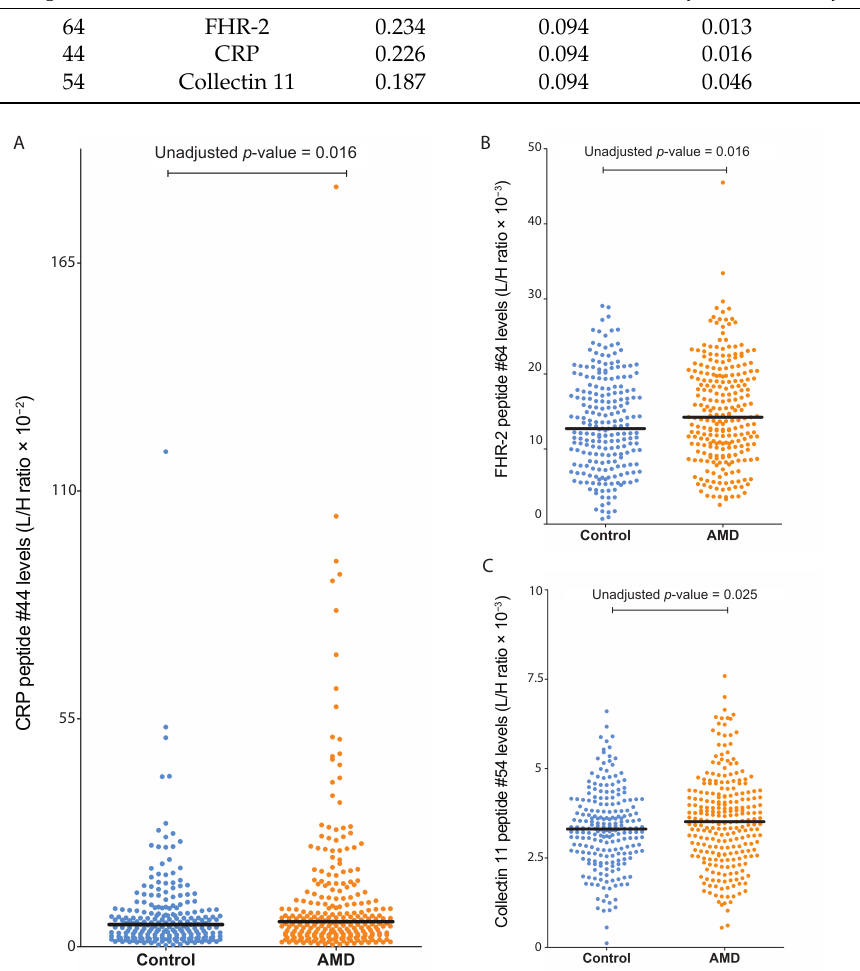
Figure 1. Suggestive association of CRP, FHR-2 and collectin-11 peptide levels with AMD. Showing the distribution of peptide levels (in L/H ratio = endogenous peptide/heavy labelled standard) in blood plasma from controls and AMD patients for ( A ) CRP peptide #44 levels (ESDTSYVSLK), ( B ) FHR-2 peptide #64 levels (TGDIVEFVCK), and ( C ) collectin-11 peptide #54 levels (VFIGINDLEK). p -values represent the results from the regression model that is adjusted for age, gender, BMI, smoking status and triglyceride